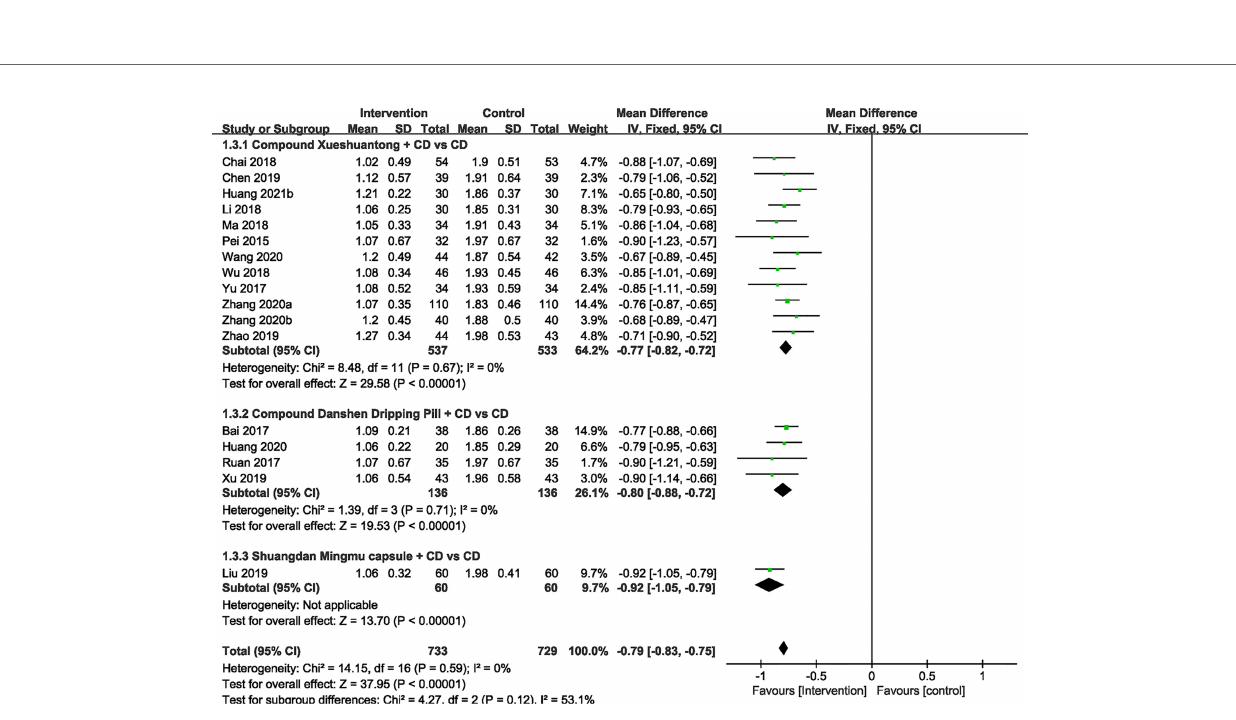
FIGURE 3 | Forest plots of comparison of ocular fundus signs for CPMs plus CD versus CD alone. (A) Microaneurysm volume, (B) Microaneurysm